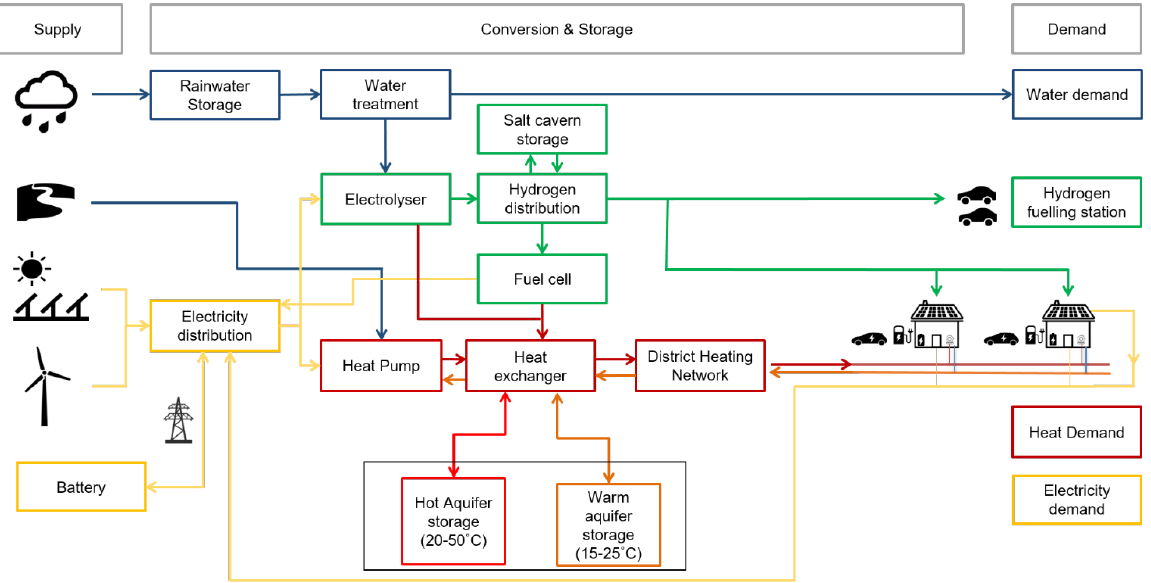
Figure 1. Schematic overview of the power-to-X model with all components and interactions. We distinguish a water (blue), electricity (yellow), hydrogen (green) and heat (red/orange) part in the system, with multiple connections between, i.e., water and hydrogen, water and heat, hydrogen and heat and electricity and heat. The demands are focused on the built environment, in which different houses with multiple demands are considered. Energy demands can be fulfilled locally by PV on roofs or a local PV or wind park, but remaining demands can be fulfilled by the grid as well. All model components shown in the figure are described in more detail in the supplementary information.